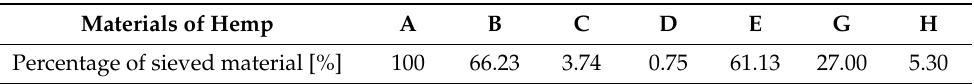
Table 2. Percentages of fractions obtained by seeding. Materials of